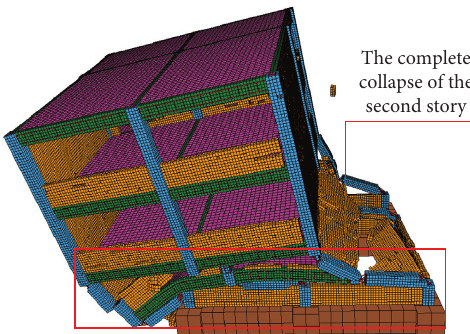
Figure 33: Second-floor collapse of the simulation